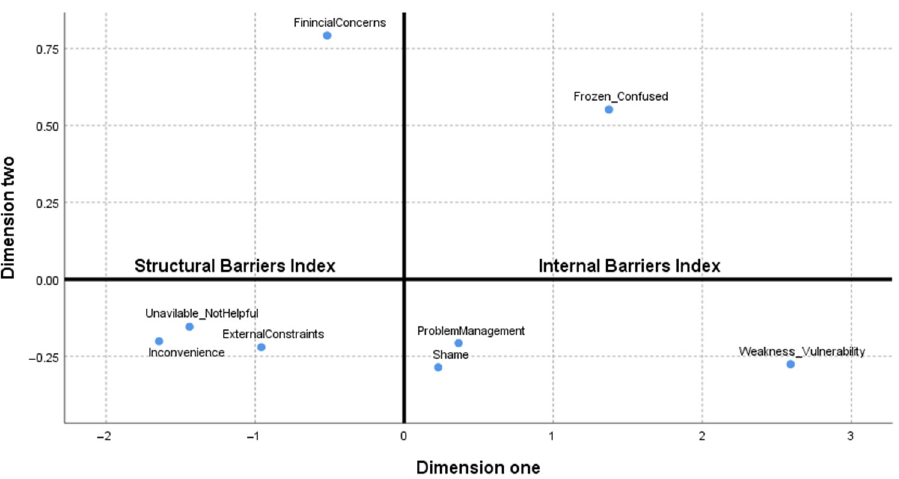
Figure 2. The structural and internal barriers indices of BHS-TR. Convergent and Discriminant